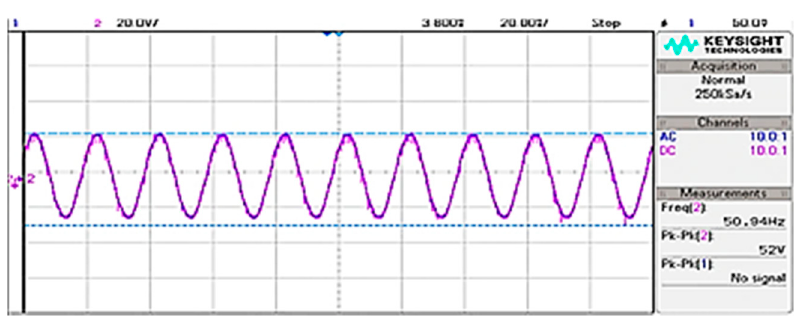
Figure 22. Phase to phase voltage across resistive load.